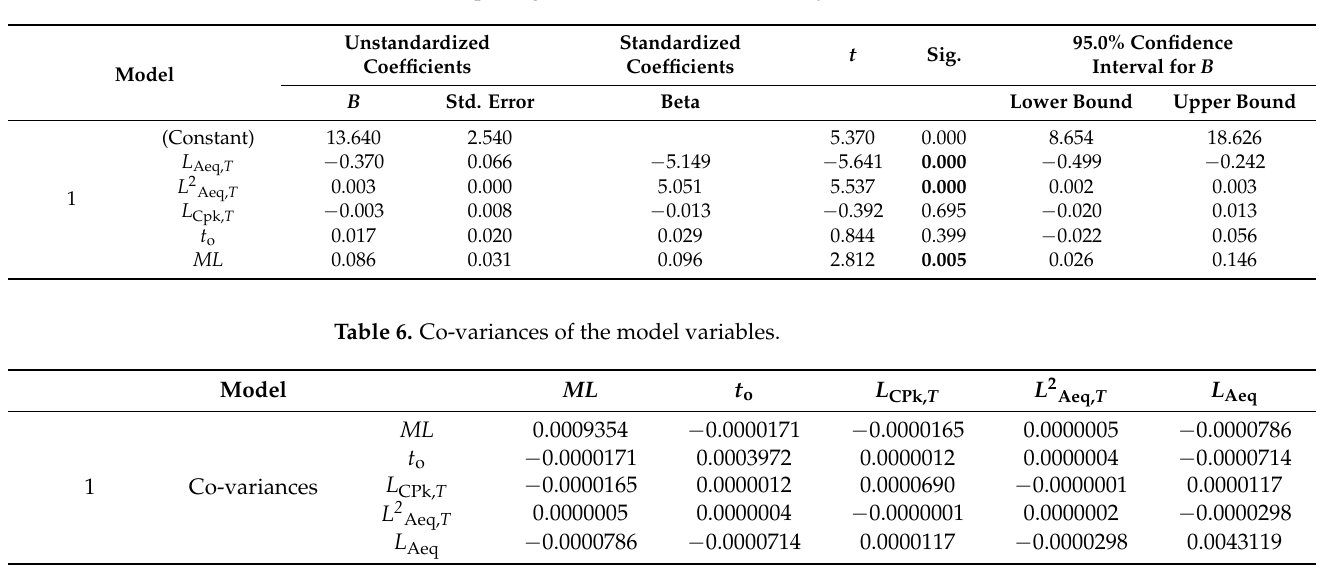
Table 5. Multiple regression and correlation analysis.